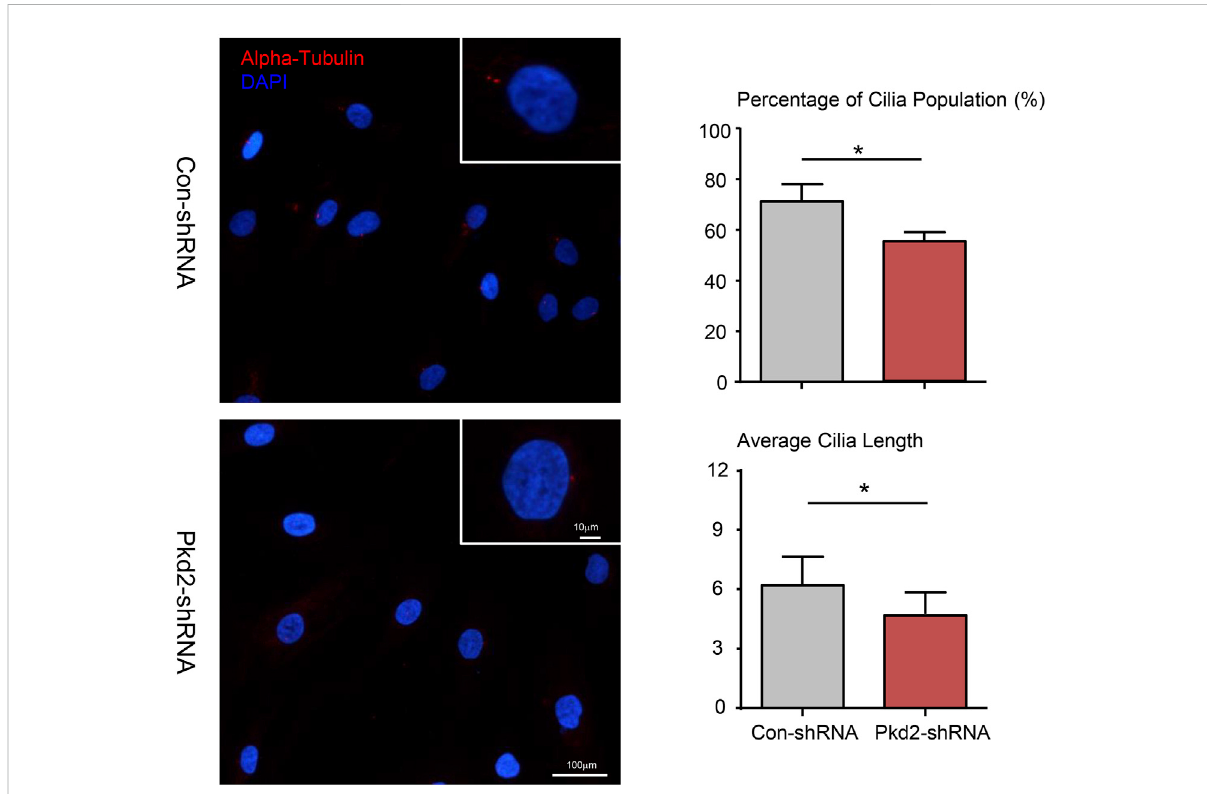
FIGURE 4 EffectofPC2knockdownonprimaryciliaformationofhASC.AftertreatedwithPKD2shRNA,primarycilia(red)subcellularlocalizationinhASCs wasobserved byimmunocyto fl uorescent.DAPIwasused tohighlightnuclei (blue). Scalebar:10 µm.Thecilia population frequencyand theaverage cilia length were measured in hASCs. Values are the mean ± SEM. * p < 0.05, ** p < 0.01. Experiments =